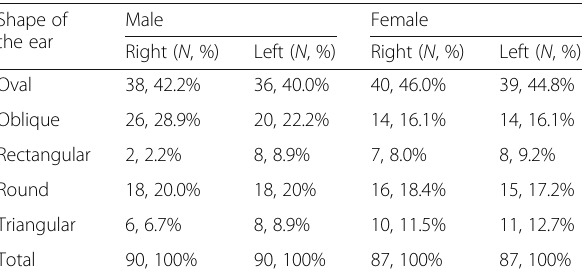
Table 1 Shape of the ear in males ( N = 90) and females ( N = 87) bilaterally